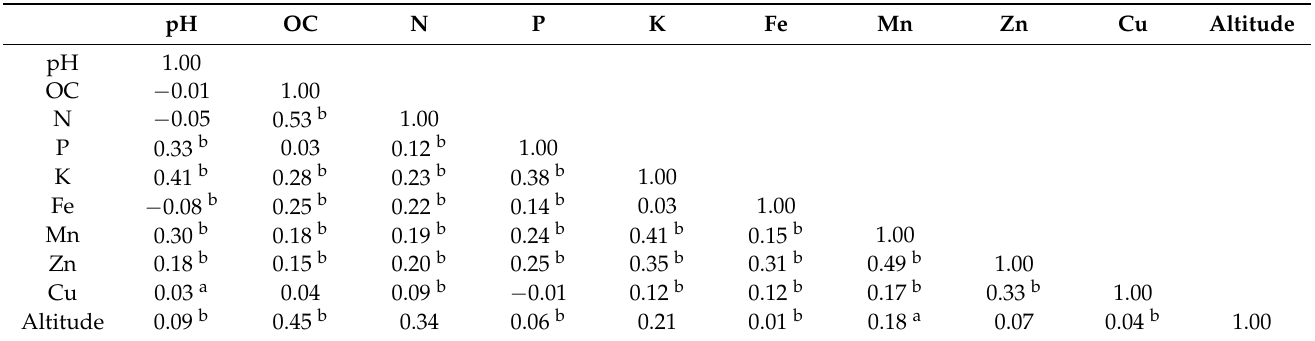
Table 3. Correlation matrix for soil properties in India’s north-eastern Himalayan